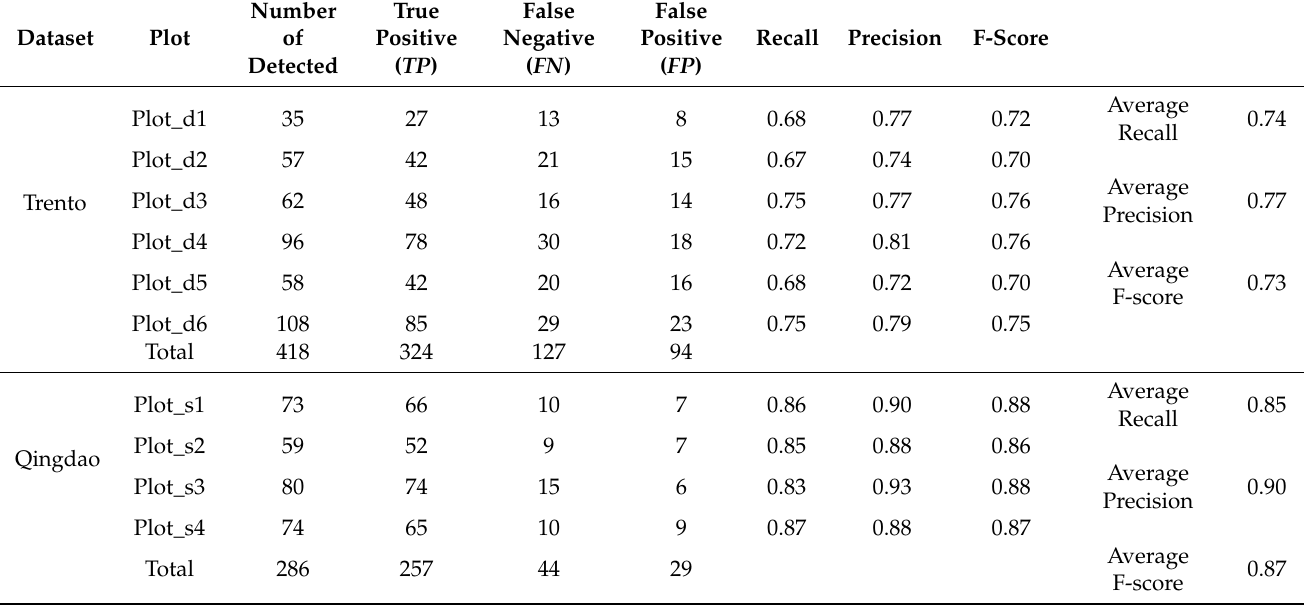
Table 3. ITS results by MS for the ten sample